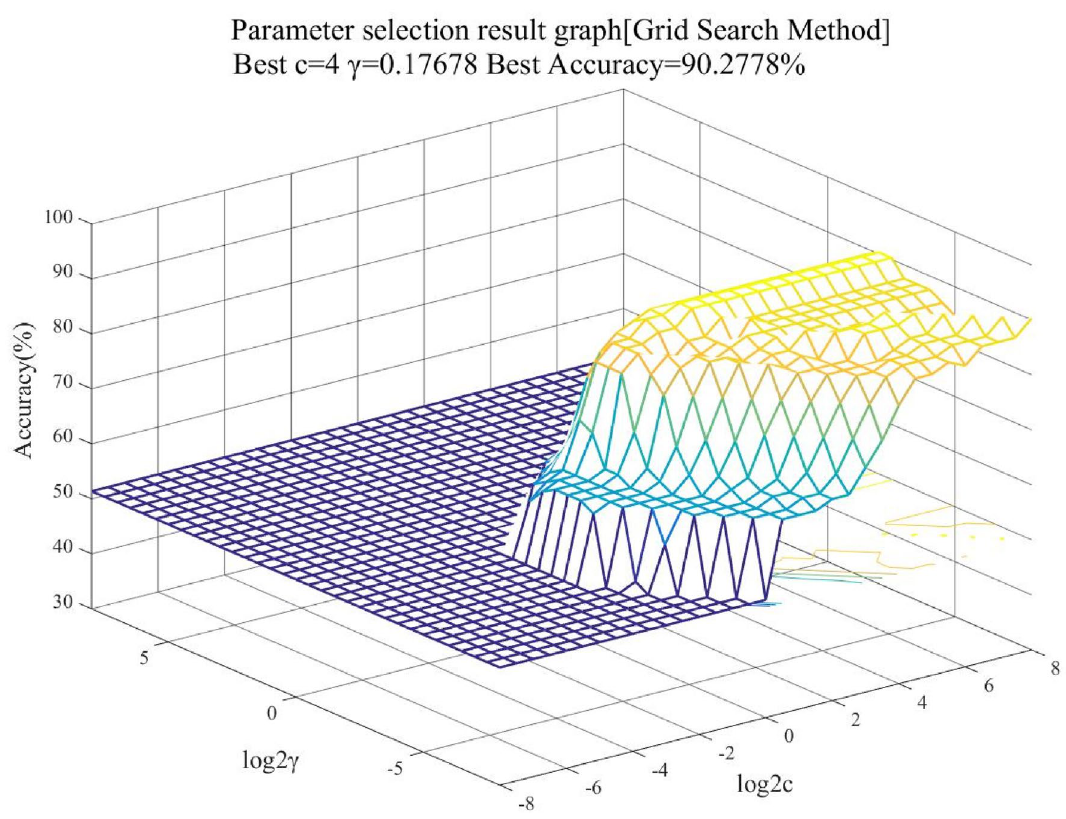
Figure 3. Support Vector Machines evaluation accuracy based on pairs of ( C, γ ). (Figure no. 3 was drawn using Matlab software with version no. Matlab 2020 and link: https:// ww2. mathw orks. cn/).